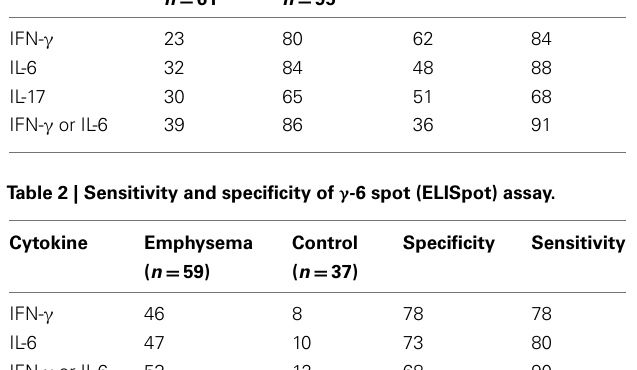
FIGURE 4 | Longitudinal study of association between autoreactiveT cells and physiological decline. The change in 6-min walk distance (6MWD) in meters over 2years is plotted against the fold change of CD4 + T cells in ever-smokers ( n = 90) with emphysema (A) IFN- γ and (B) IL-6 in response to elastin fragments over nil stimulation; r =− 0.35, P = 0.0006 for IFN- γ and r =− 0.41, P < 0.0001 for IL-6).The production of IFN- γ [ (C) , red] and IL-6 [ (D) , blue] by peripheral blood CD4 + T cells stimulated by elastin fragments is plotted in volunteers that had oxygen desaturation (filled circles, n = 62) during the initial or subsequent 6-min walk tests and those that did not (open circles, n = 35). Significantly higher levels of IFN- γ ( P = 0.0002) and IL-6 ( P < 0.0001) were measured in volunteers with oxygen